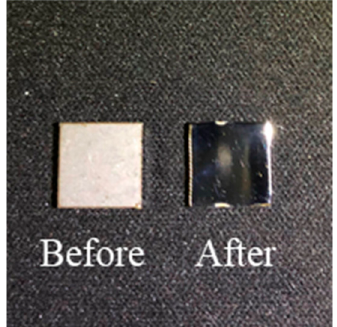
Figure 5. Contrast of workpiece before and after polishing.